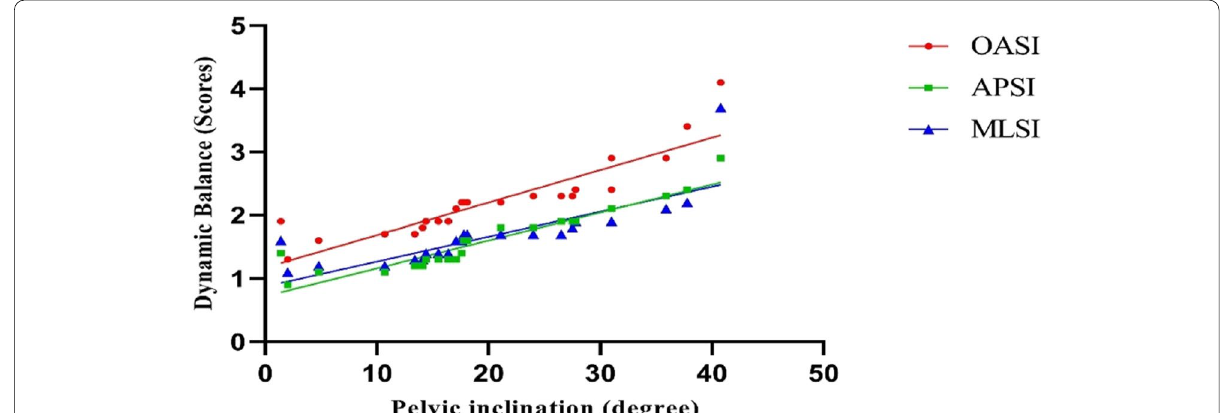
Fig. 2 Correlation between standing balance and pelvic inclination in studied